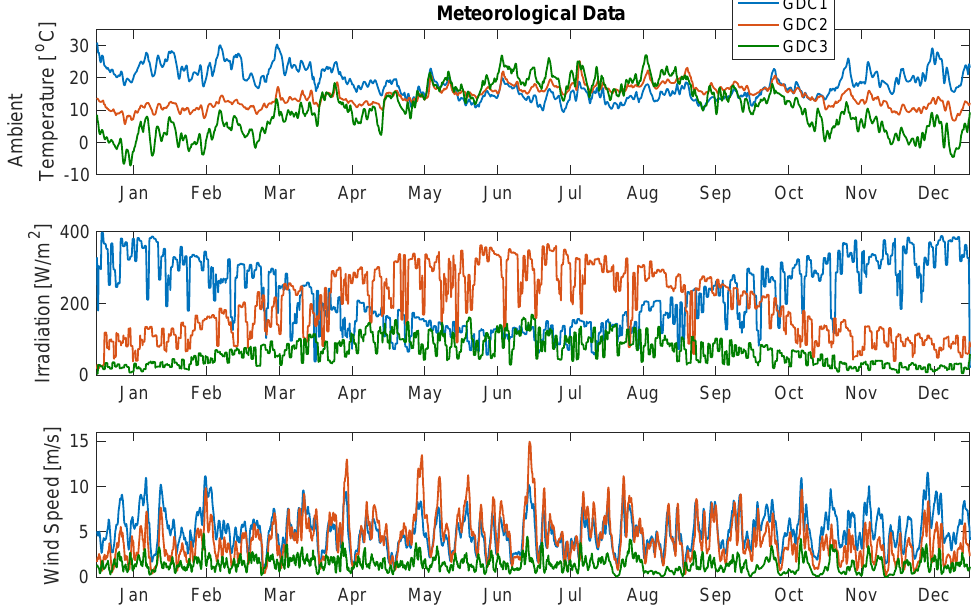
Figure 3. 24-day simple moving average of meteorological data for the three regions in the case